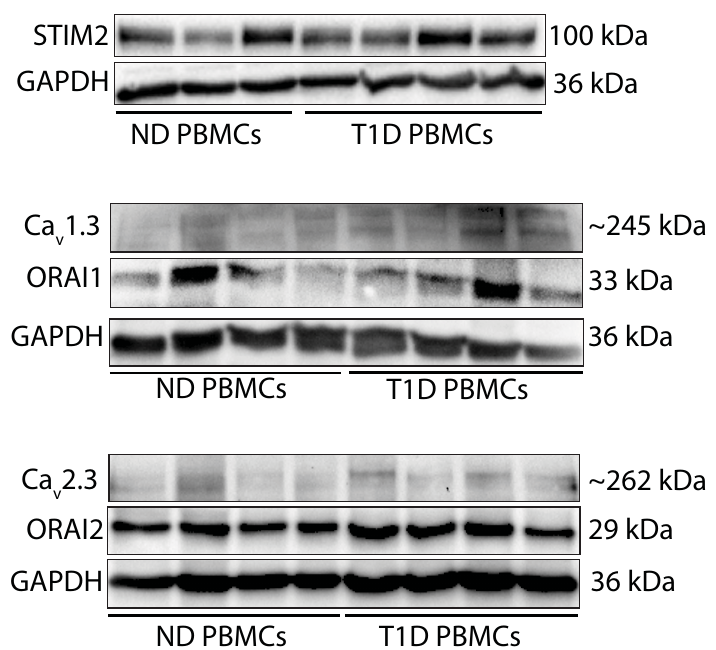
Fig 4. Western blot analysis. Western blot analysis showing the expression of Ca 2+ sensor protein stromal interaction molecules (STIM) 2, voltage-gated Ca 2+ (Ca V ) channel subunits Cav1.3 and Cav2.3, and Ca 2+ release-activated Ca 2+ (CRAC) channel proteins ORAI1 and 2 in PBMCs from ND (n = 3 or 4) and T1D (n = 4) individuals. GAPDH (Glyceraldehyde 3-phosphate dehydrogenase) served as loading controls.